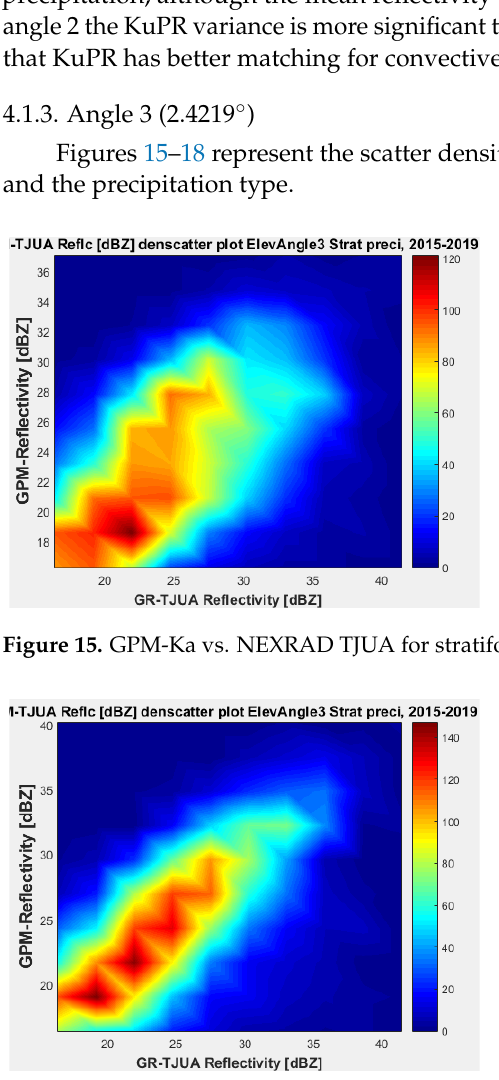
Figure 16. GPM ‐ Ku vs. NEXRAD TJUA for stratiform precipitation (angle 3).